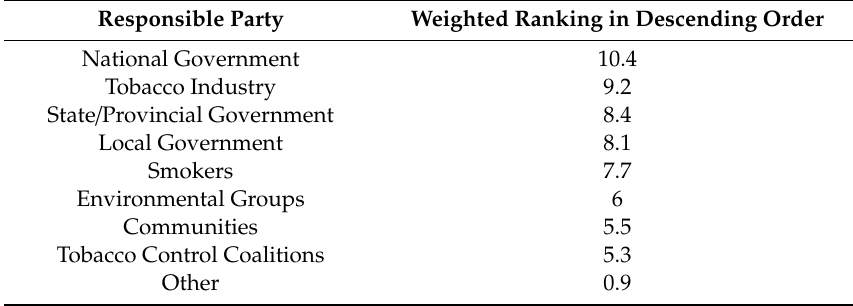
Table 3. Rankings of organizational responsibility for tobacco product waste (TPW) (and ranking metric) by members of Framework Convention Alliance, 2019 ( N = 65).